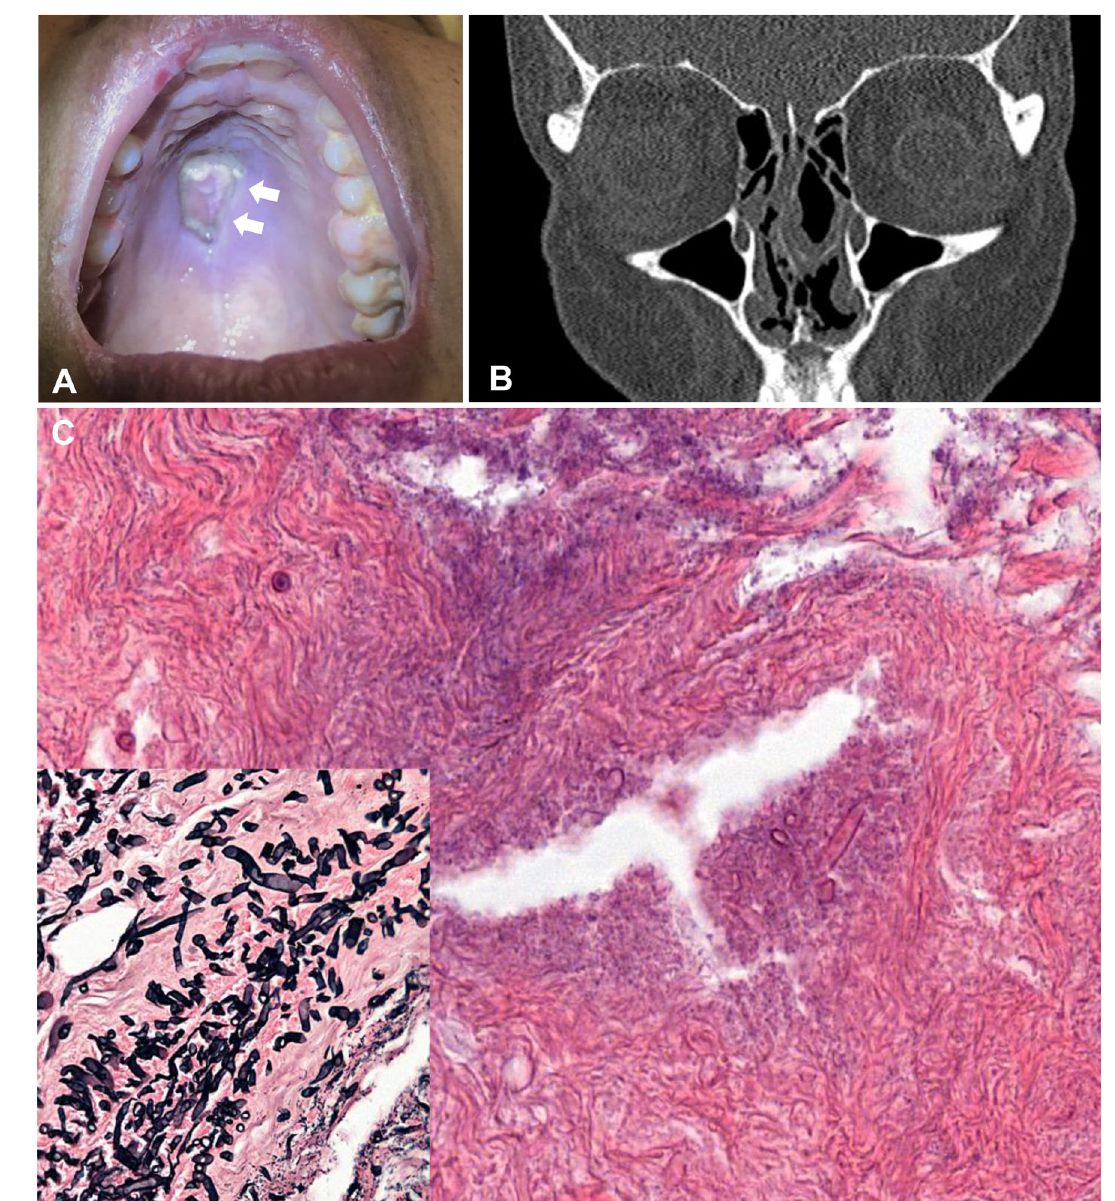
Fig. 1 Initial palatine lesion ( A , withe arrow) and CT scan before surgery showing palatine and septum lysis ( B ). Massive necrosis of the palate biopsy ( C ), hyphae identified by routine hematoxylin-eosin stain broad and ribbon-like hyphea in blood vessel stained with Grocott ( C , insert)